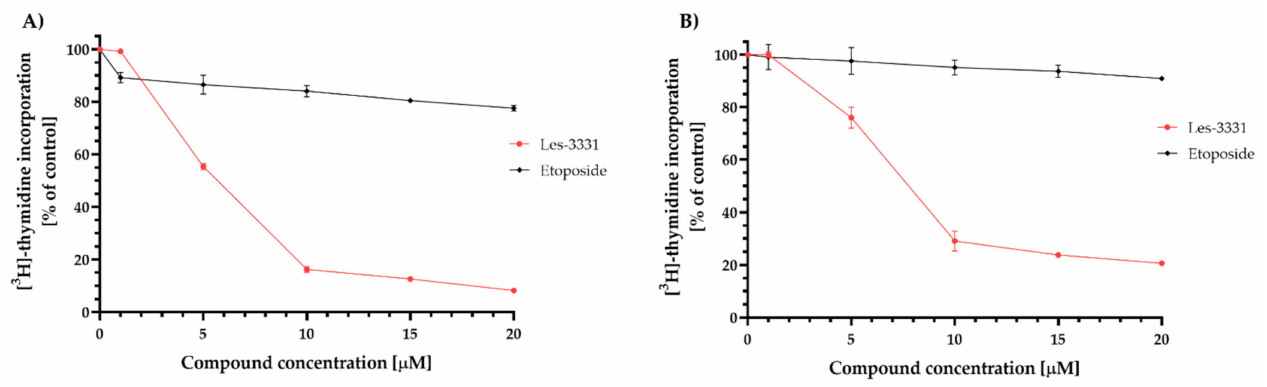
Figure 3. The influence of Les-3331 and reference drug on cell proliferation in MCF-7 ( A ) and MDA-MB-231 ( B ) cancer cell lines. Antiproliferative activity was measured after 24 h incubation of cancer cells with Les-3331 and a reference drug (etoposide) using [ 3 H]-thymidine incorporation assay. Mean ± SD from three independent experiments performed in duplicate is